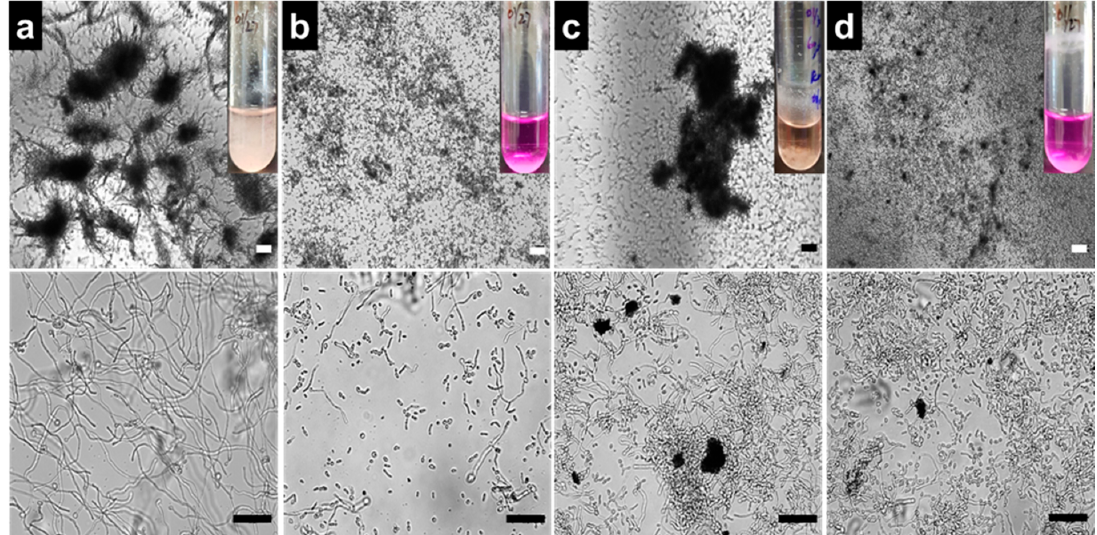
Figure 3. Light microscopy images of C. albicans hyphae formation: Micrographs showing denser filament formation in the presence of none ( a ), complete inhibition of hyphae by AZ at 2 µg/mL ( b ), slow hyphae development in the presence of 2 µg/mL GO ( c ), and hyphae inhibition in the presence of 2 µg/mL GO-AZ ( d ) with high yeast cell number. Insets show the color change of the medium from pink to colorless which exhibit the yeast-to-hyphae transition without or with samples. Lower panels showing the magnified views of the same. Scale bar = 50 µm.